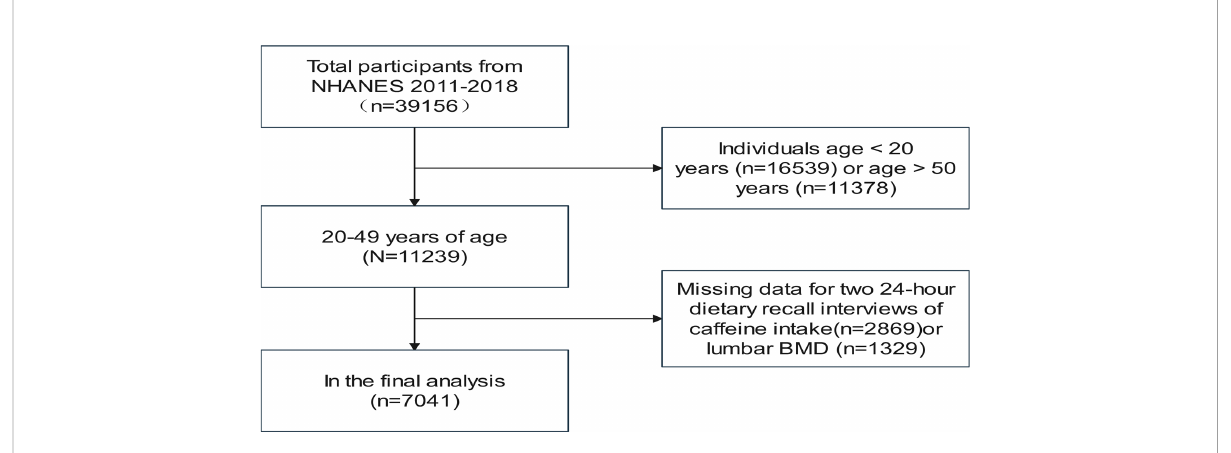
FIGURE 1 Flowchart of participants